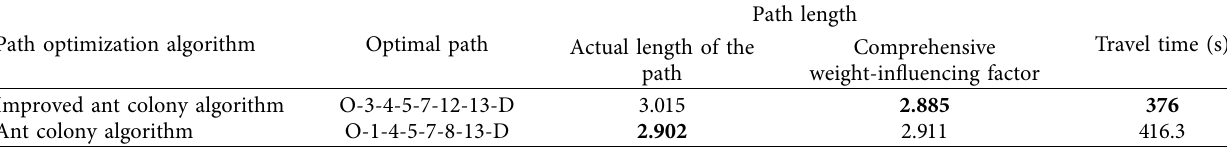
Table 8: Comparison of various algorithms in Simulated Road Network.